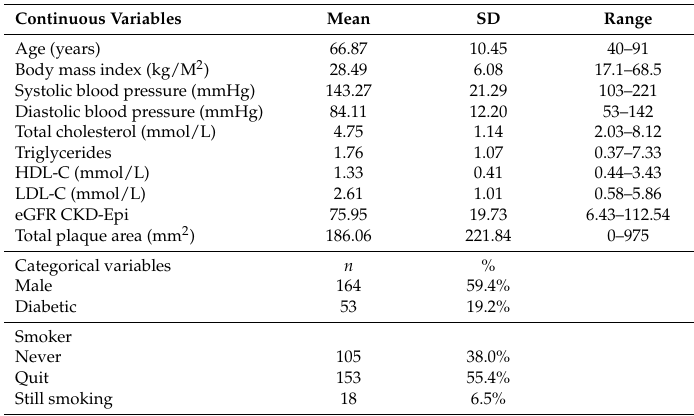
Table 1. Characteristics of the study population. n = 276.